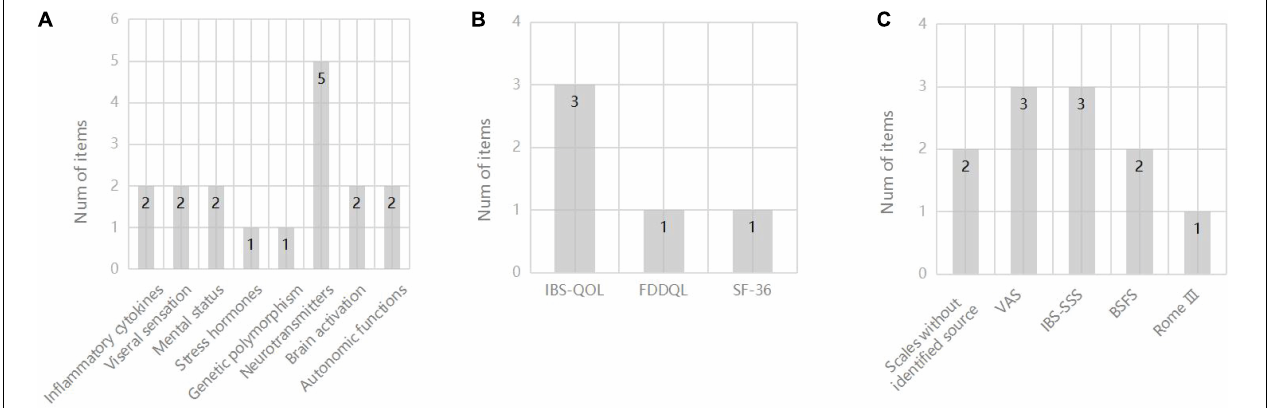
FIGURE 2 | (A) Number of items for different scales of IBS-D symptoms; (B) Number of items for different scales of QOL; (C) Number of items for different mechanism research. BSFS, Bristol Stool Form Scale; FDDQL, functional digestive diseases quality of life; IBS-QOL, IBS quality of life; IBS-SSS, IBS severity scoring system; SF-36, 36-Item Short Form Survey; VAS, visual analog